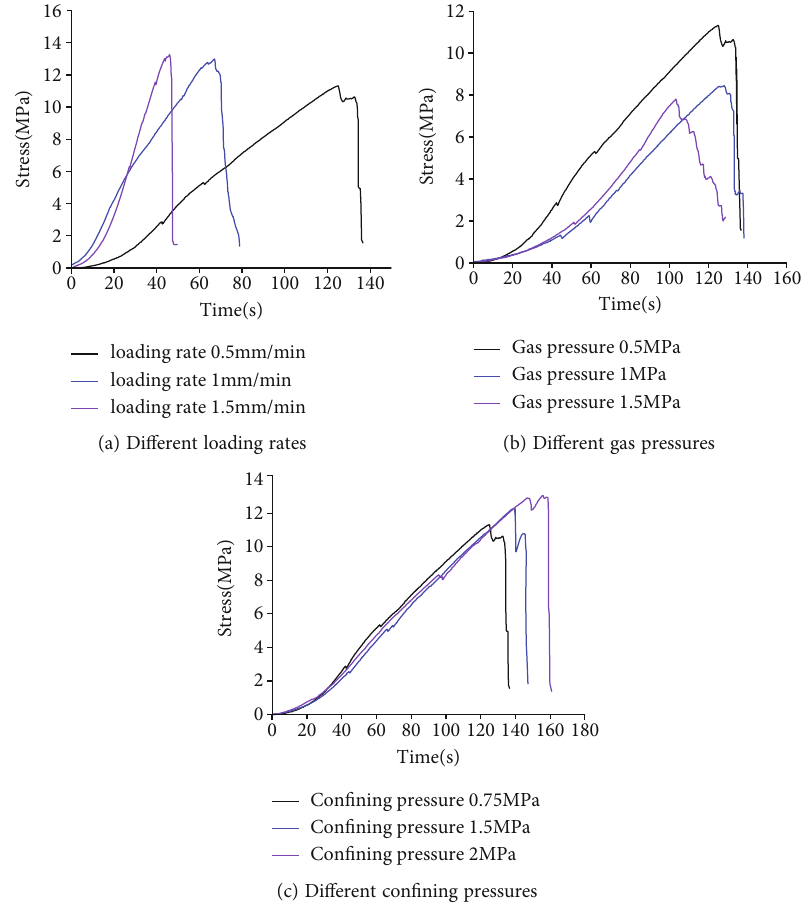
Figure 3: Time-axial stress curves under di ff erent loading